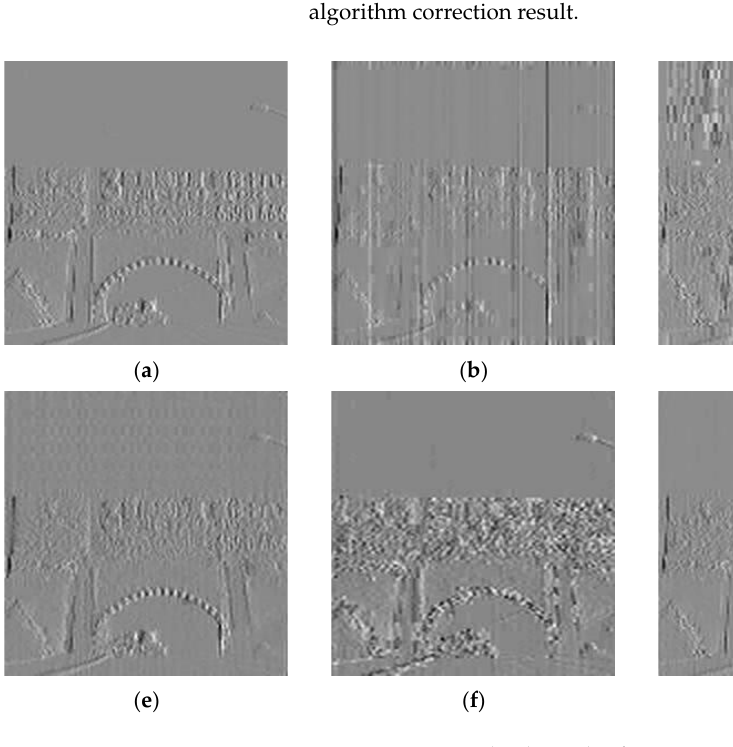
Figure 20. Vertical subgraph of correction results. ( a ) Ideal result; ( b ) BFTH algorithm